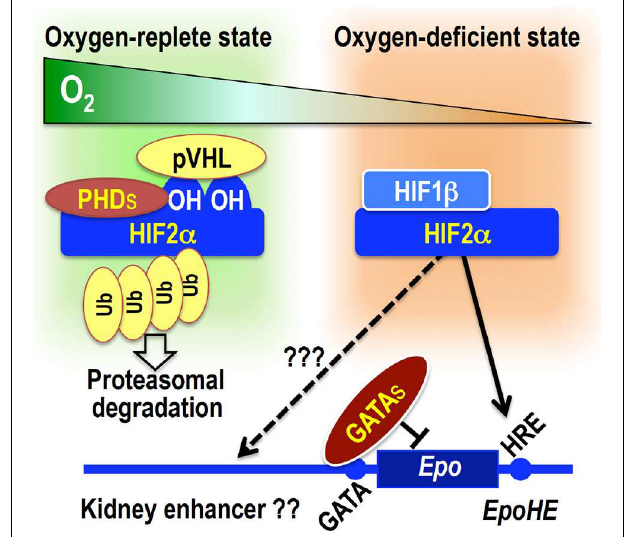
FIGURE 2 | ON–OFF regulation of Epo synthesis in REPs. (A) Oxygen deficiency turns OFF-REPs into ON-REPs by turning on “ Epo gene switch.” (B) REPs are primarily in the “OFF” state (OFF-REPs, brown dots) under normal oxygen conditions. Under acute anemic conditions, some clusters of OFF-REPs turn into ON-REPs (green dots). The distribution of ON-REPs extends toward hypoxic cortical areas (orange). Strikingly, most OFF-REPs turn into ON-REPs under chronic anemia. This recruitment of ON-REPs determines the total amount of Epo secreted by the kidneys. regions for renal Epo gene expression. It has been surmised that